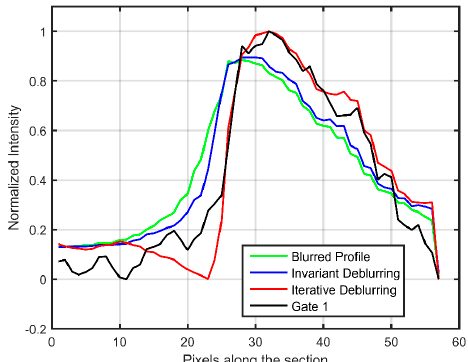
Figure 16. Intensity values for pixels on a section passing through the jet perpendicular to the sense of rotation. Rotation is toward decreasing pixel values.